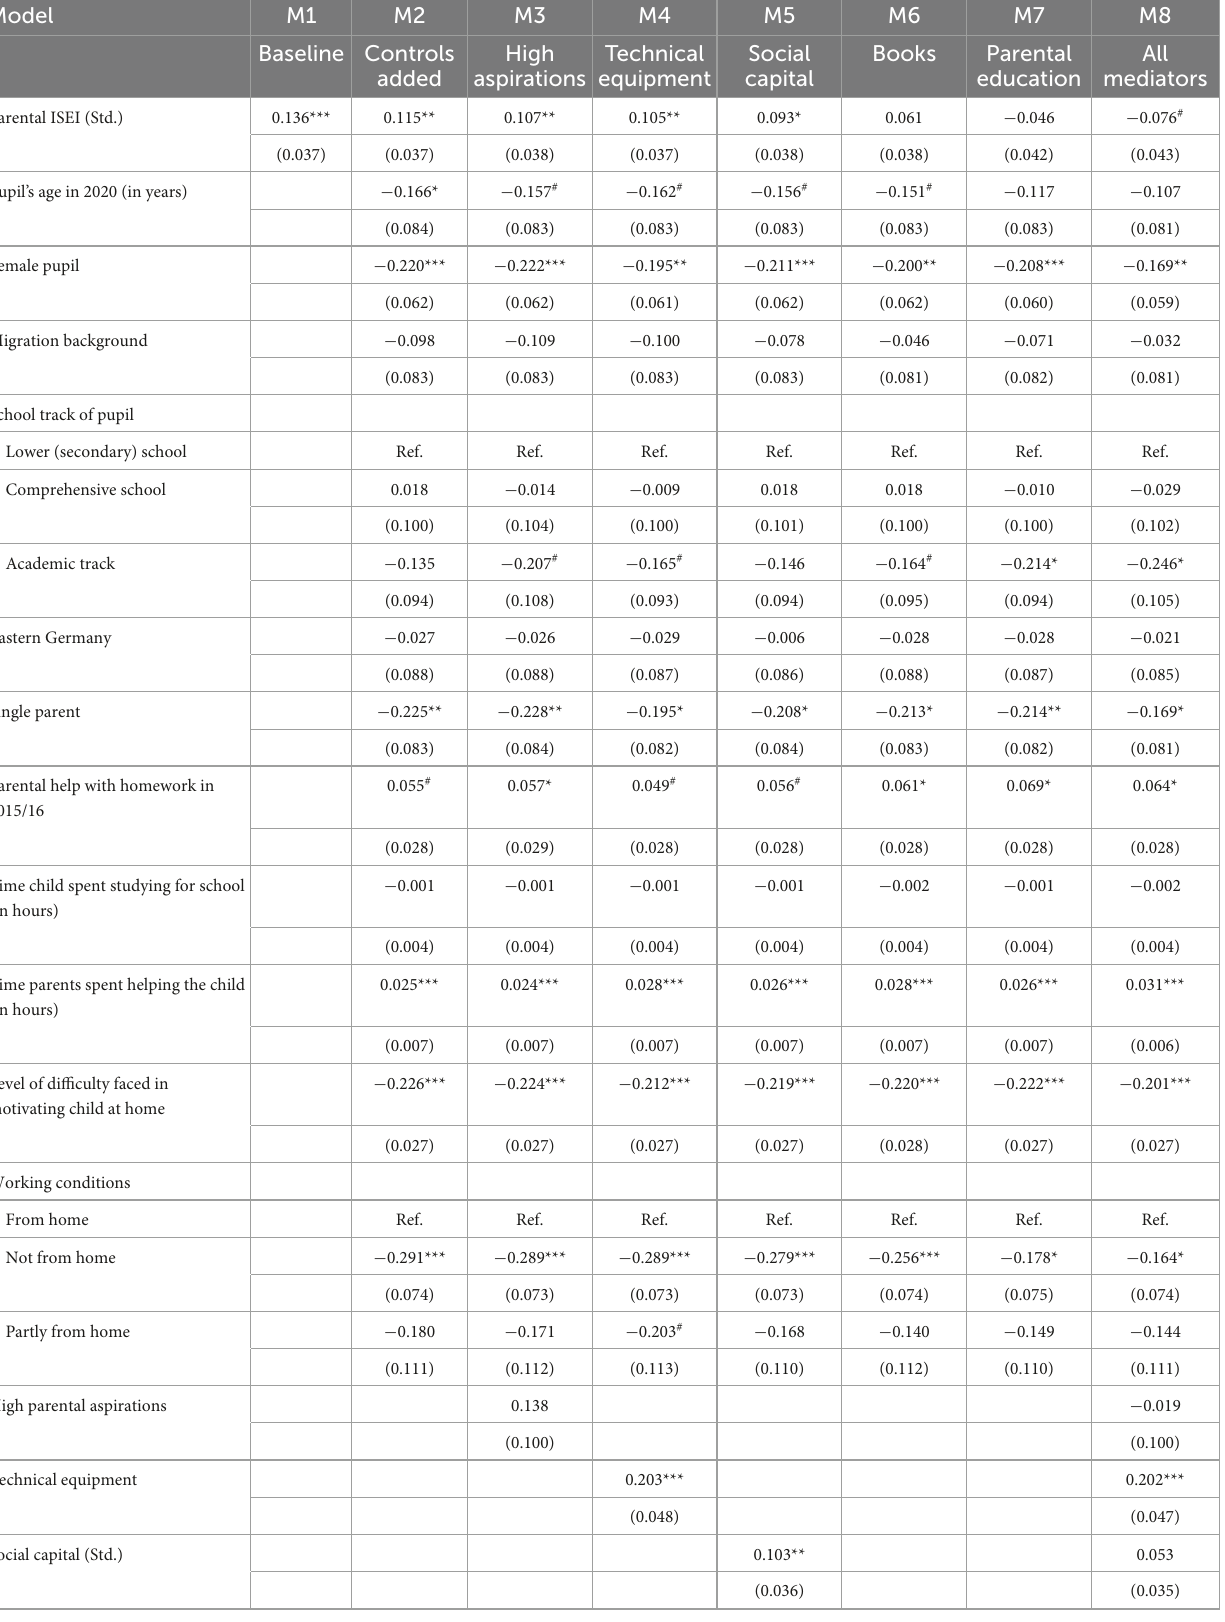
TABLE 2 Determinants of parental support during